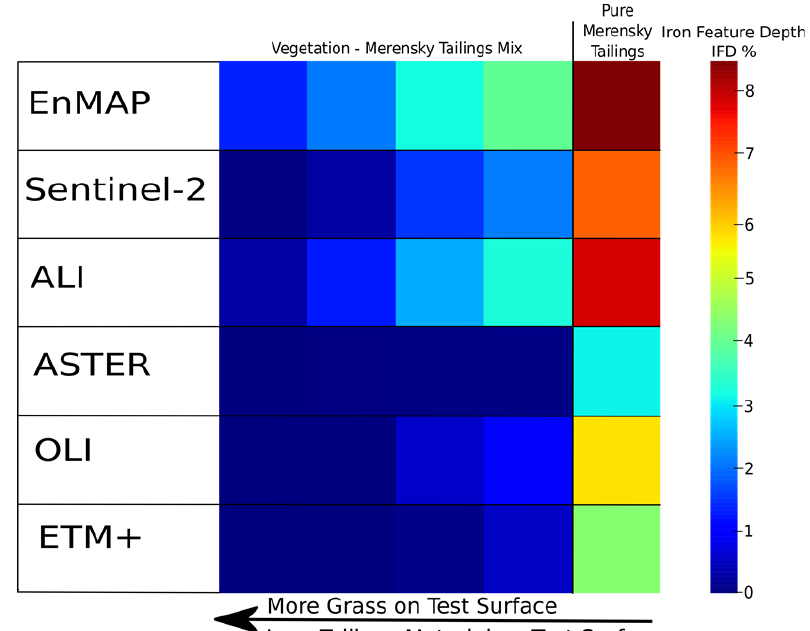
Figure 11. Iron feature depth analysis from in situ ASD field-spectroscopy data from PGE tailings material and mixtures of tailings material with